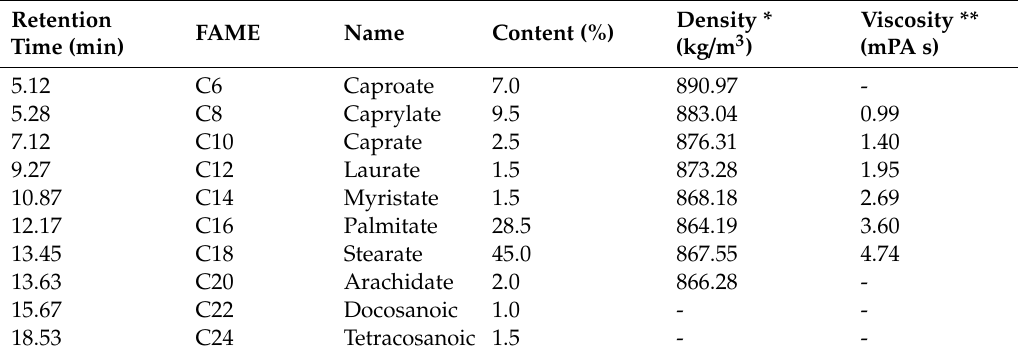
Table 1. FAME characteristics in C. subglobosa according to Figure 3.